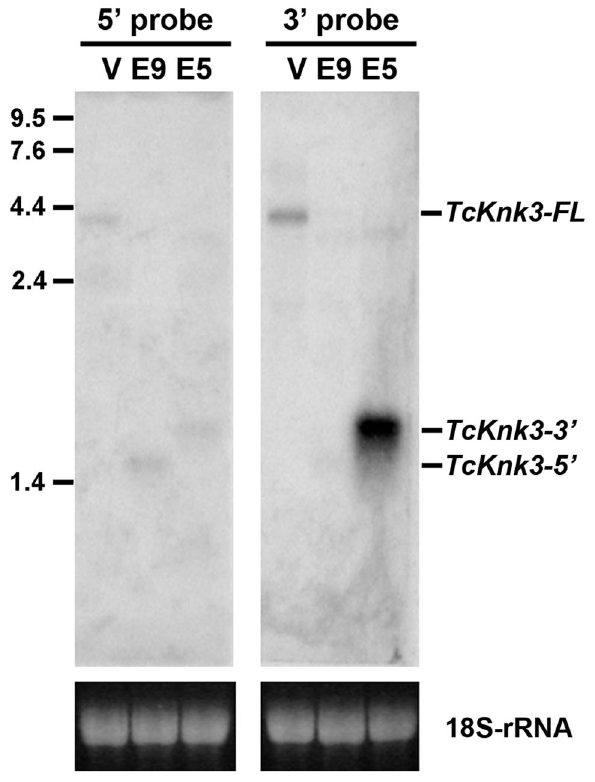
Figure 2. Northern blot analysis of TcKnk3 transcripts using 32 P- labeled 5 9 -terminal and 3 9 -terminal probes. Ten m g of extracted RNA from: V, TcVer ; E9, TcKnk3 -exon 9; E5, TcKnk3 -exon 5 specific dsRNA-treated pharate adult insects was loaded onto an 1.5% agarose gel, transferred on to the nitrocellulose membrane and hybridized with 32 2 P-labeled 5 9 -terminal or 3 9 -terminal probe as described in Materials and Methods. There is a small amount of cross-hybridization of the 5 9 - probe and the RNA that gives a strong signal with the 3 9 -probe (presumed 3 9 -transcript; left panel, lane marked E5). The indicated sizes of the bands were based on the length of the cloned fragments and assuming a poly-A tail of , 200 nucleotides.